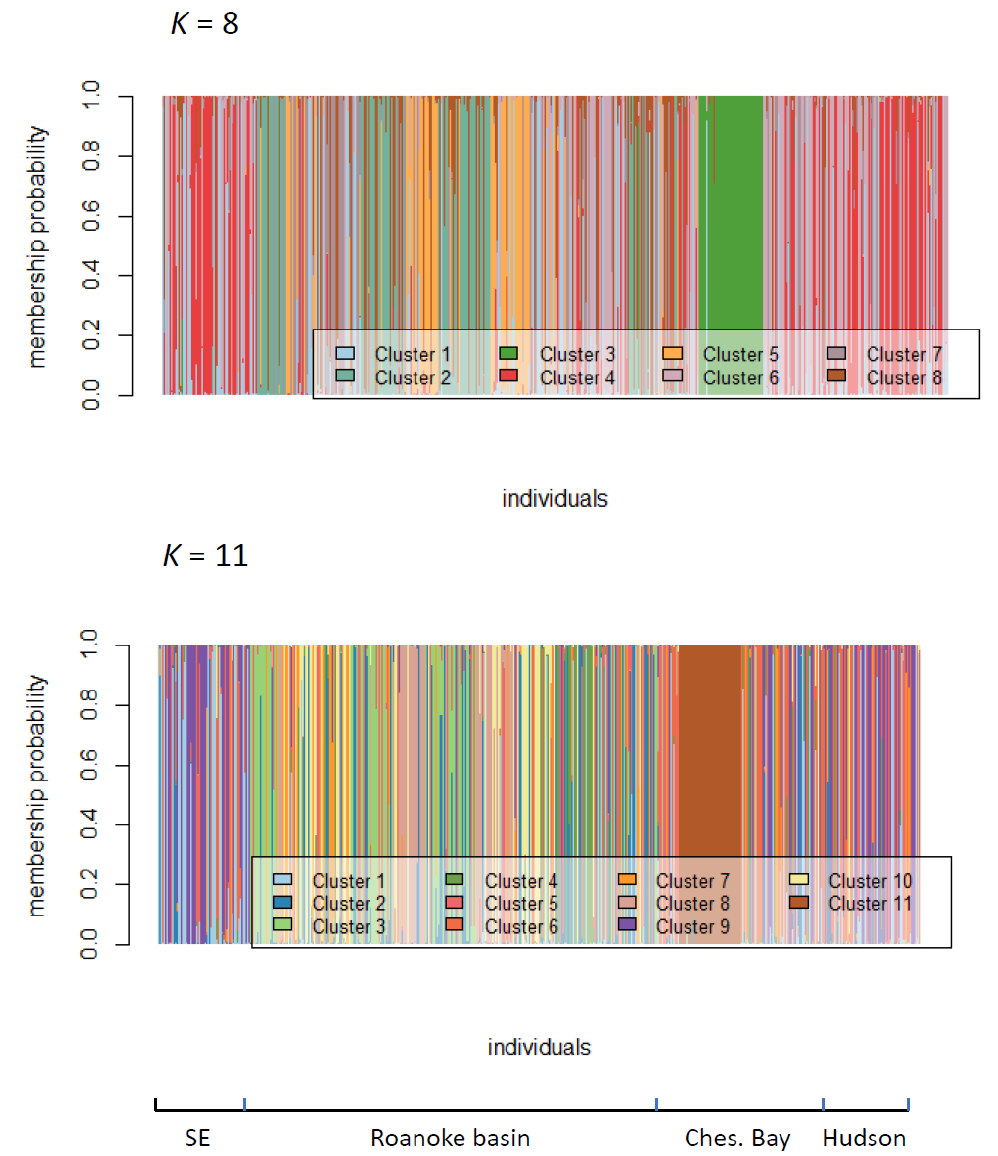
Figure 3. DAPC plot for 837 striped bass from 16 collections along the Atlantic coast, respectively grouped into K = 8 and K = 11 clusters. Populations in the Southeast include: lakes Marion and